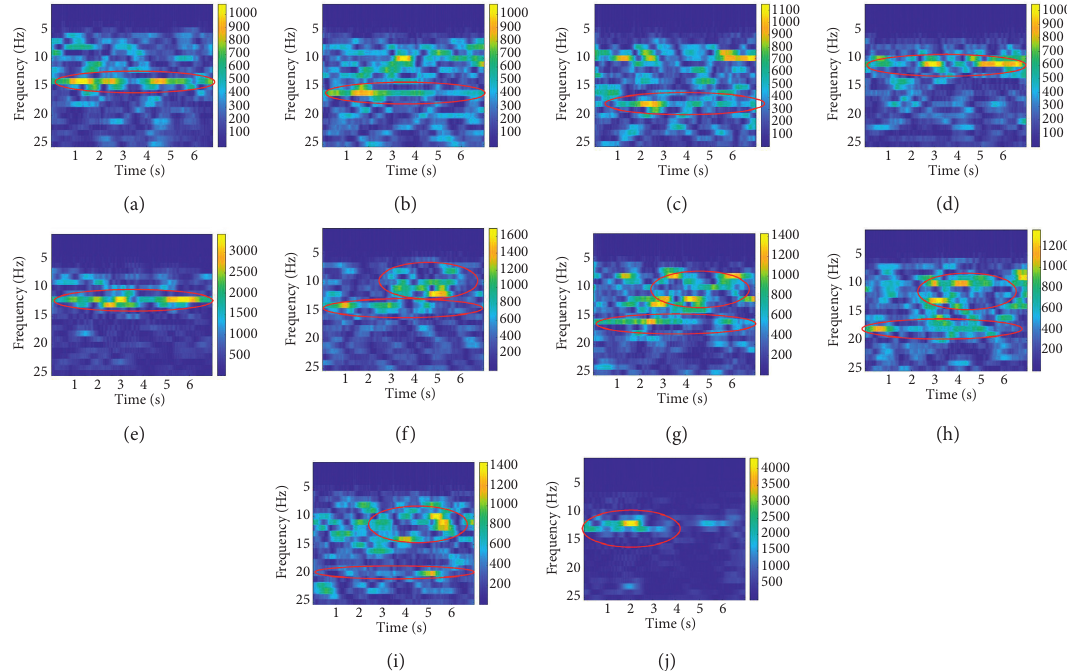
Figure 5: The time and the frequency domain features for 10 different mental tasks: (a) gaze 6.6Hz, (b) gaze 7.5Hz, (c) gaze 8.57Hz, (d) gaze 9.6Hz, (e) MI task, (f) gaze 6.6Hz+MI, (g) gaze 7.5 Hz+MI, (h) gaze 8.57Hz+MI, (i) gaze 9.6Hz+MI, and (j) idle state. The red circle marks the feature for easy